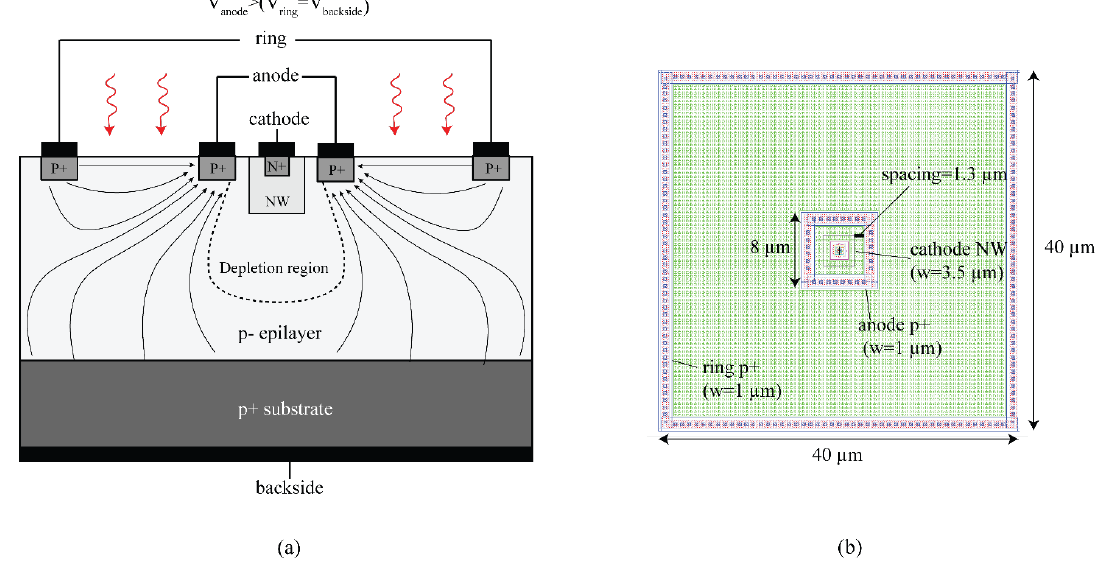
Figure 19. Cross section of CA-SPAD-1, lines with arrows indicate the direction of photo-electrons, dotted line represents the boundary of the depletion region ( a ) and top-view of the layout of CA-SPAD-1 with dimensions indicated ( b ).